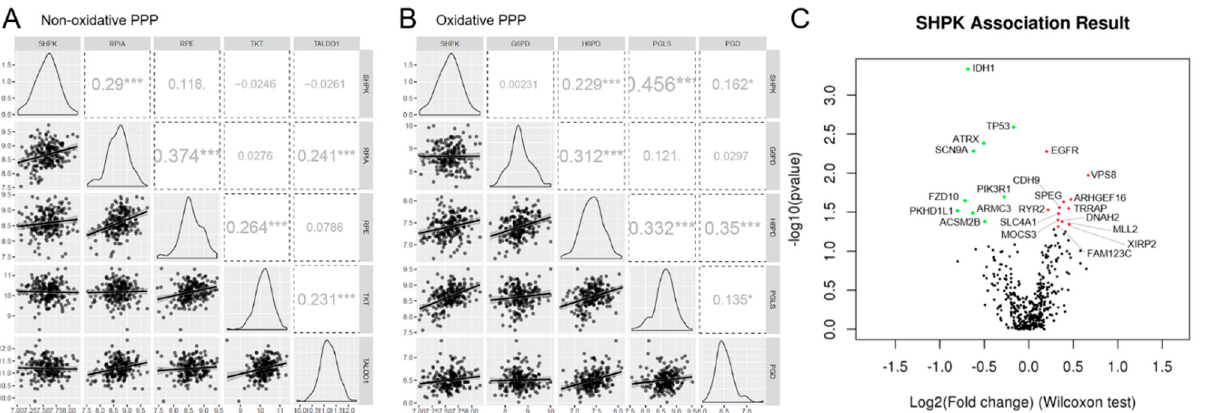
Figure 2. SHPK correlation and association analysis. Pearson correlation analysis between mRNA expression of enzymes constituting the nonoxidative ( A ) and oxidative ( B ) arms of PPP. The figure shows the scatter plot with regression line for each correlation (bottom diagonal), the density plot (middle diagonal), and the Pearson correlation coefficient with significance: *** p < 0.001, ** p < 0.01, * p < 0.05 (upper diagonal). ( C ) Volcano plot showing the log2 (fold change) vs. log10 ( p -value) obtained from the analysis. In green, with a negative Log2FC, statistically significant associations between the absence of mutation and SHPK mRNA overexpression and between the presence of mutation and downregulation of SHPK mRNA expression are highlighted. In red, with a positive Log2FC, statistically significant associations between the presence of the mutation and SHPK mRNA overexpression and between the absence of the mutation and downregulation of SHPK mRNA expression are highlighted.